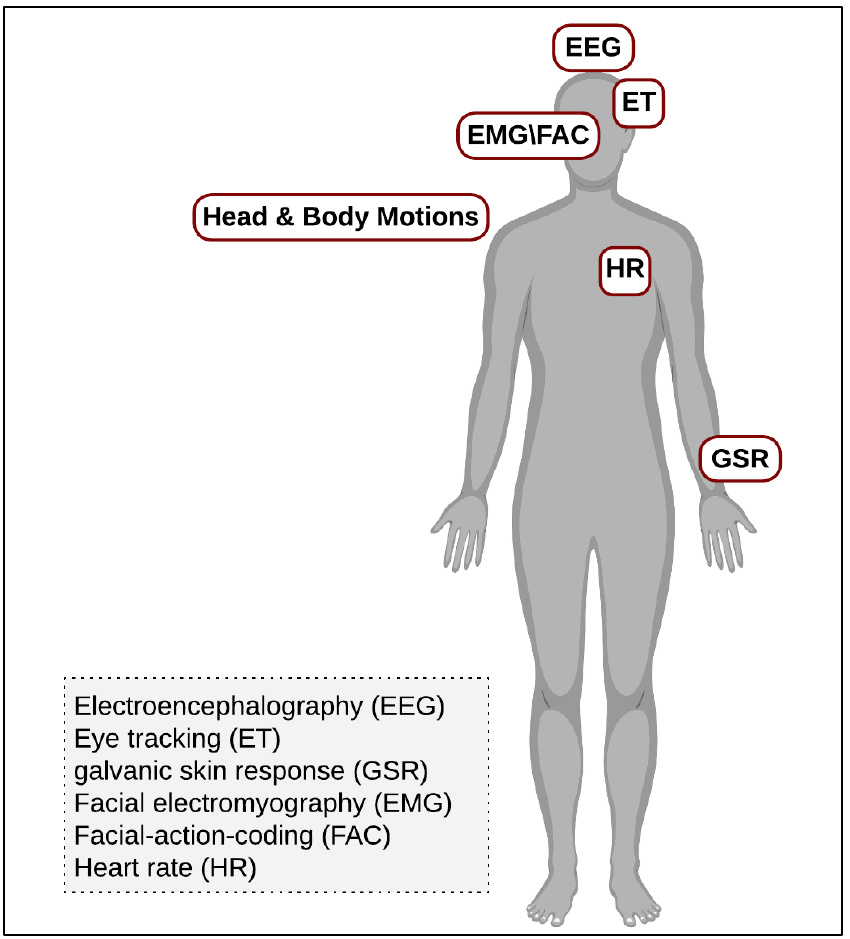
Figure 1. Most widely employed modalities in neuromarketing.